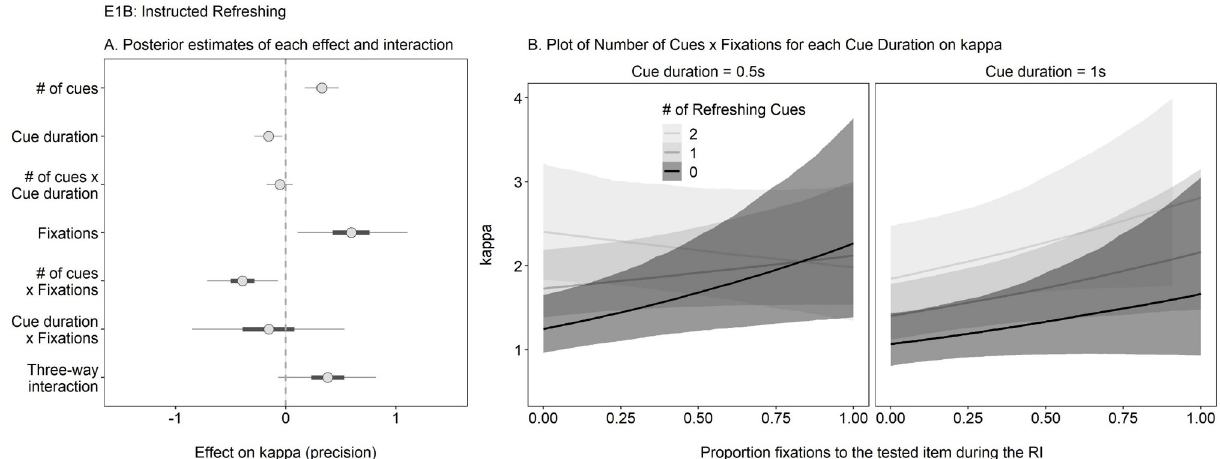
Fig 6. Research Question 3: Does Looking-at-Nothing During Instructed Refreshing Predict WM Recall Precision in Experiment 1B? Panel A Shows Posterior Estimates for the Predictors (Dot = Mean; Thin Line = 95% CI) Indicating a Credible Effect of Number of Refreshing Cues, Cue Duration, Fixations, and Interaction of Number of Cues and Fixations. Panel B Presents Model Predictions for the Interaction of Fixation Frequency and Number of Refreshing Cues for Each Cue Duration on Kappa.